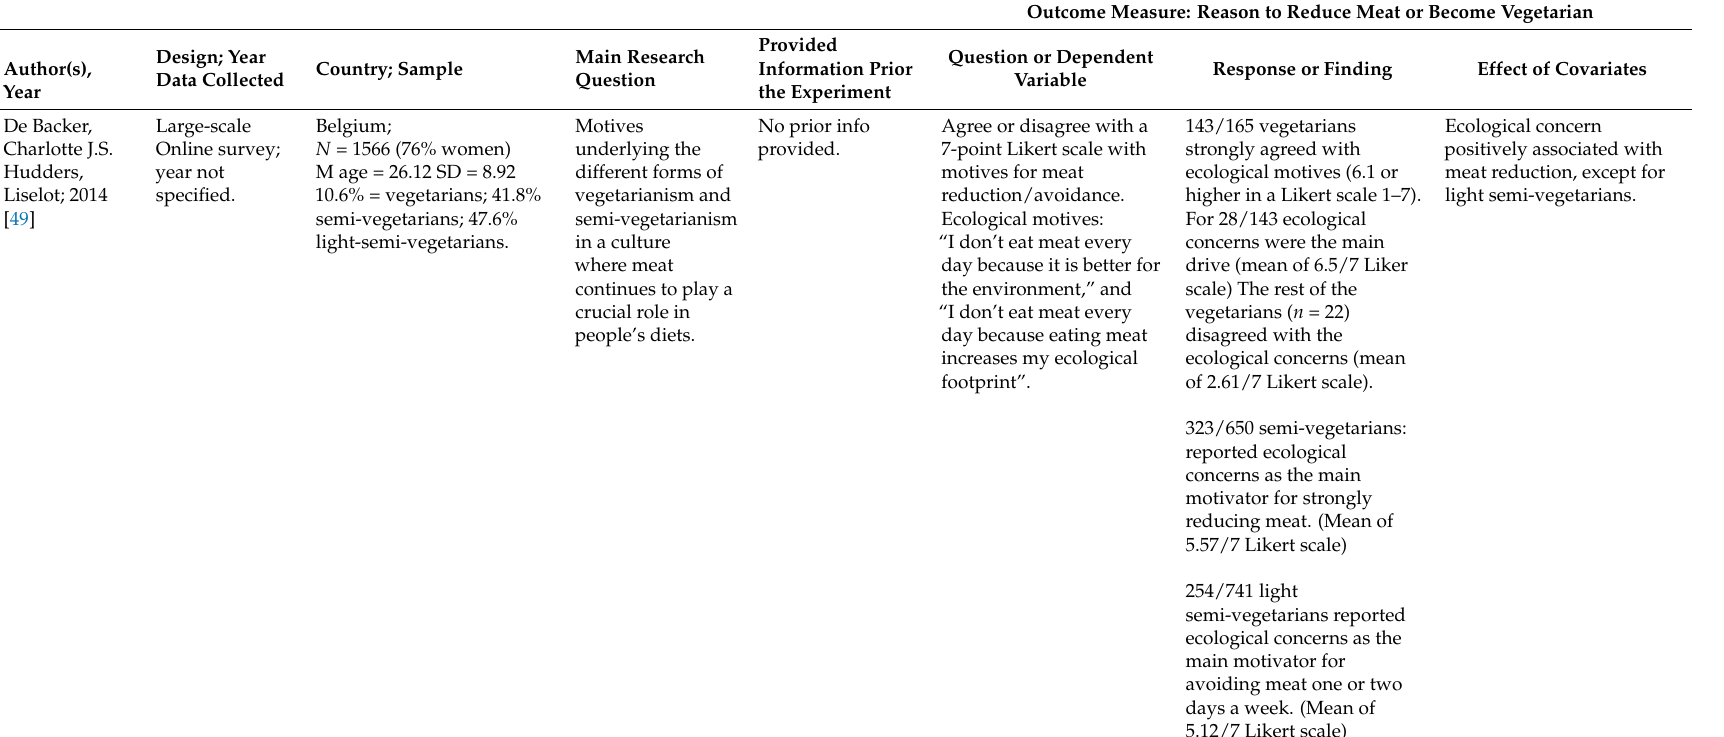
Table A3. Vegans, vegetarians, and meat consumption curtailers for environmental